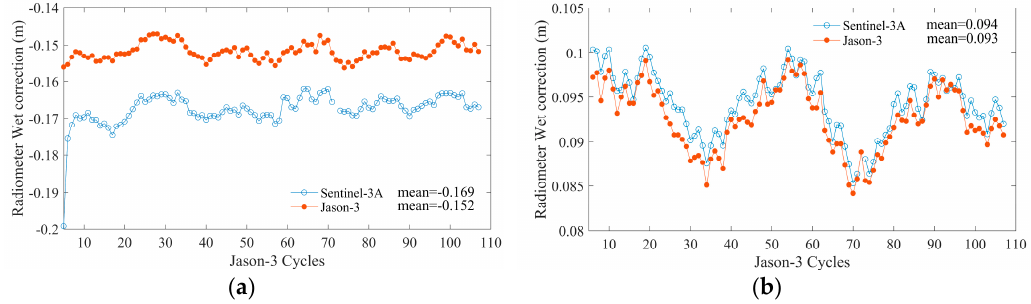
Figure 23. Comparison of cycle by cycle ( a ) means and ( b ) standard deviations of radiometer wet tropospheric corrections between Sentinel-3A and Jason-3 according to Jason-3 repeat cycles.